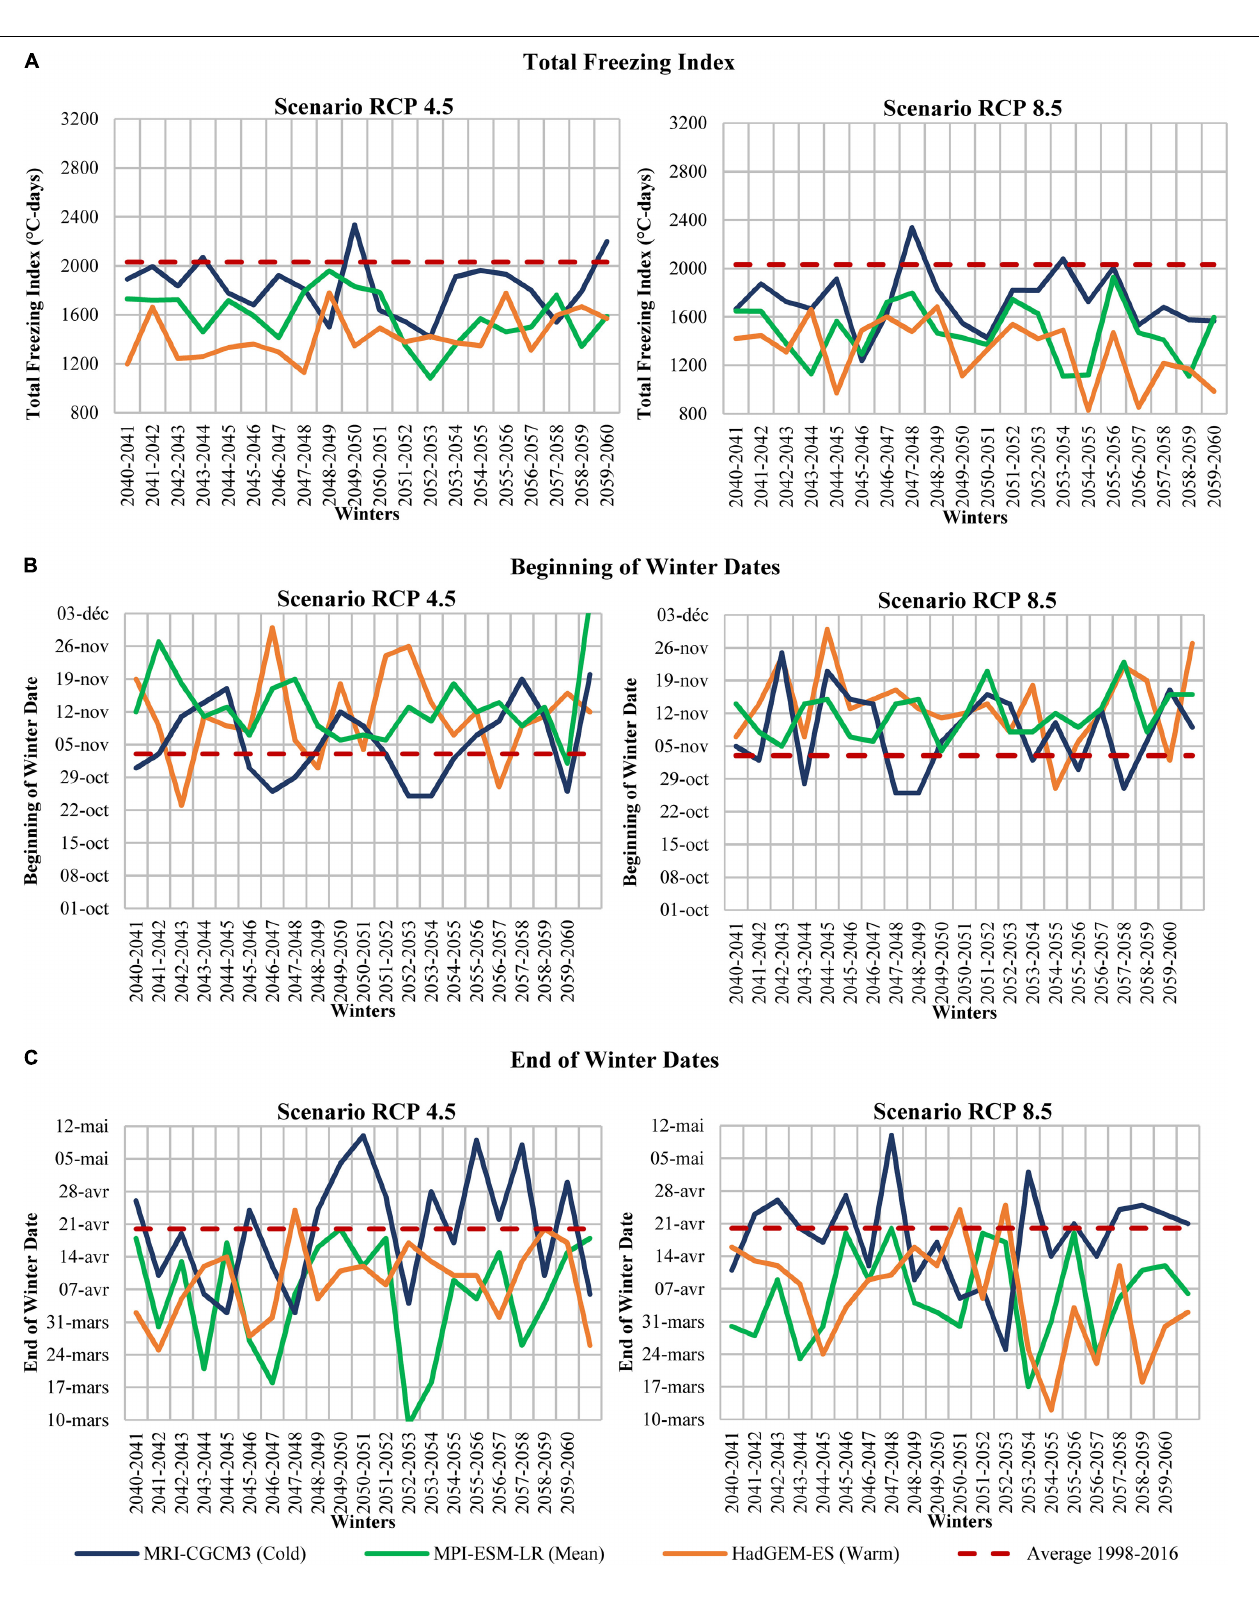
FIGURE 4 | Characteristics of projected glaciological winters at Moosonee station for the 2040–2060 period under climatic scenarios RCP4.5 (left) and RCP8.5 (right). Total freezing index (A) , beginning of winter dates (B) , and end of winter dates (C) .